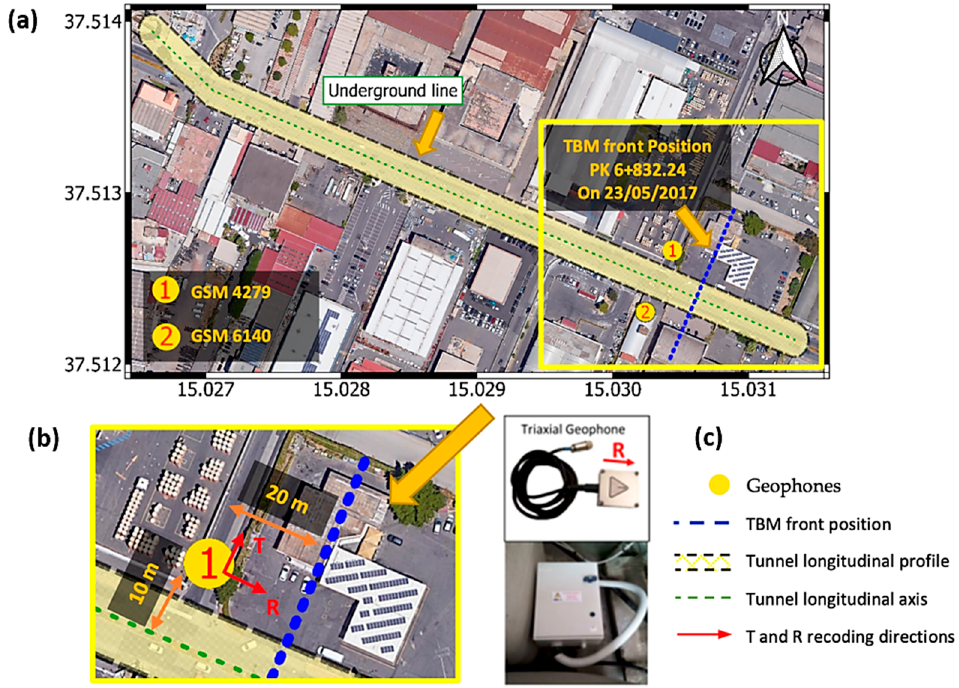
Figure 6. Layout of the geophones at the soil surface: ( a ) plan view; ( b ) zoom of the location of geophone n. 1 and TBM front; ( c ) detail of the used geophones.